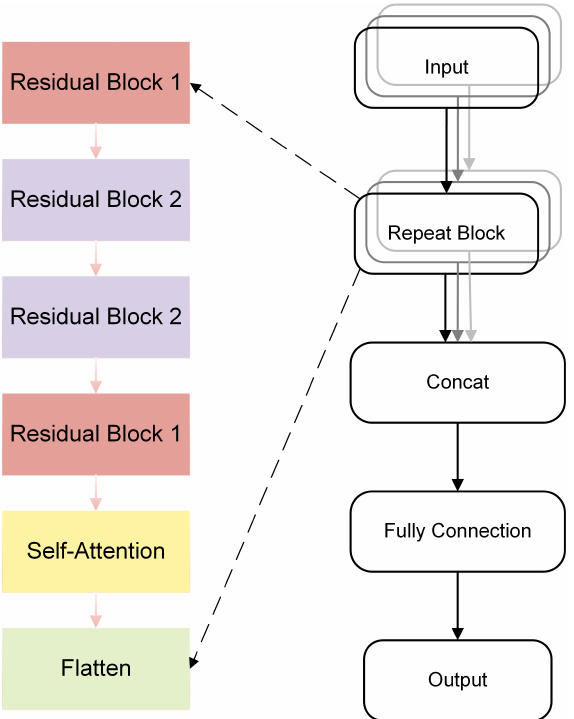
Figure 4. Overall structure of MTCAN